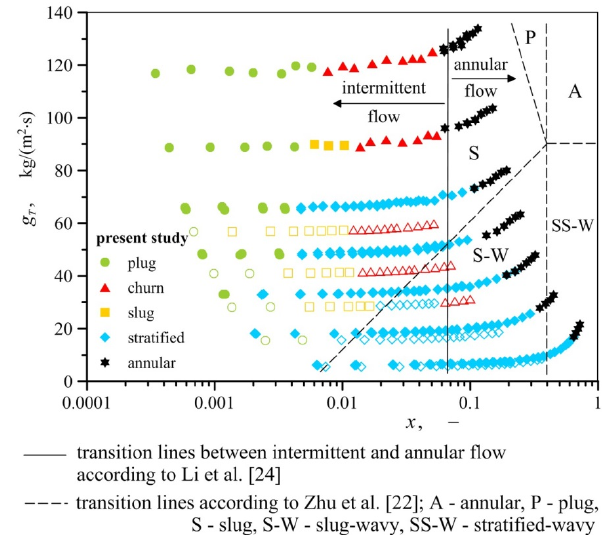
Figure 5. Air − water and air − oil flow patterns represented in the x – g T system (empty symbols refer to air − oil flow).